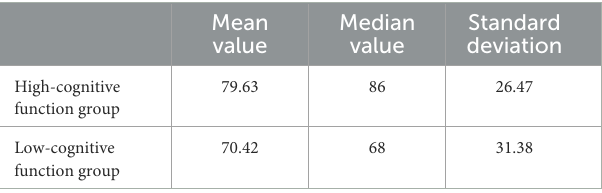
High-cognitive function group